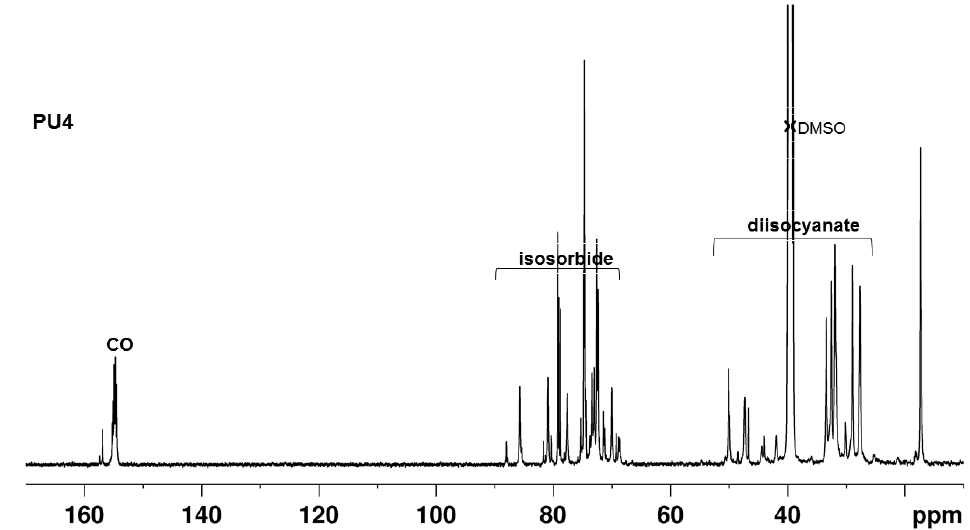
Figure 9. The 13 C{ 1 H} NMR spectrum of the PU4 in DMSO- d 6 .